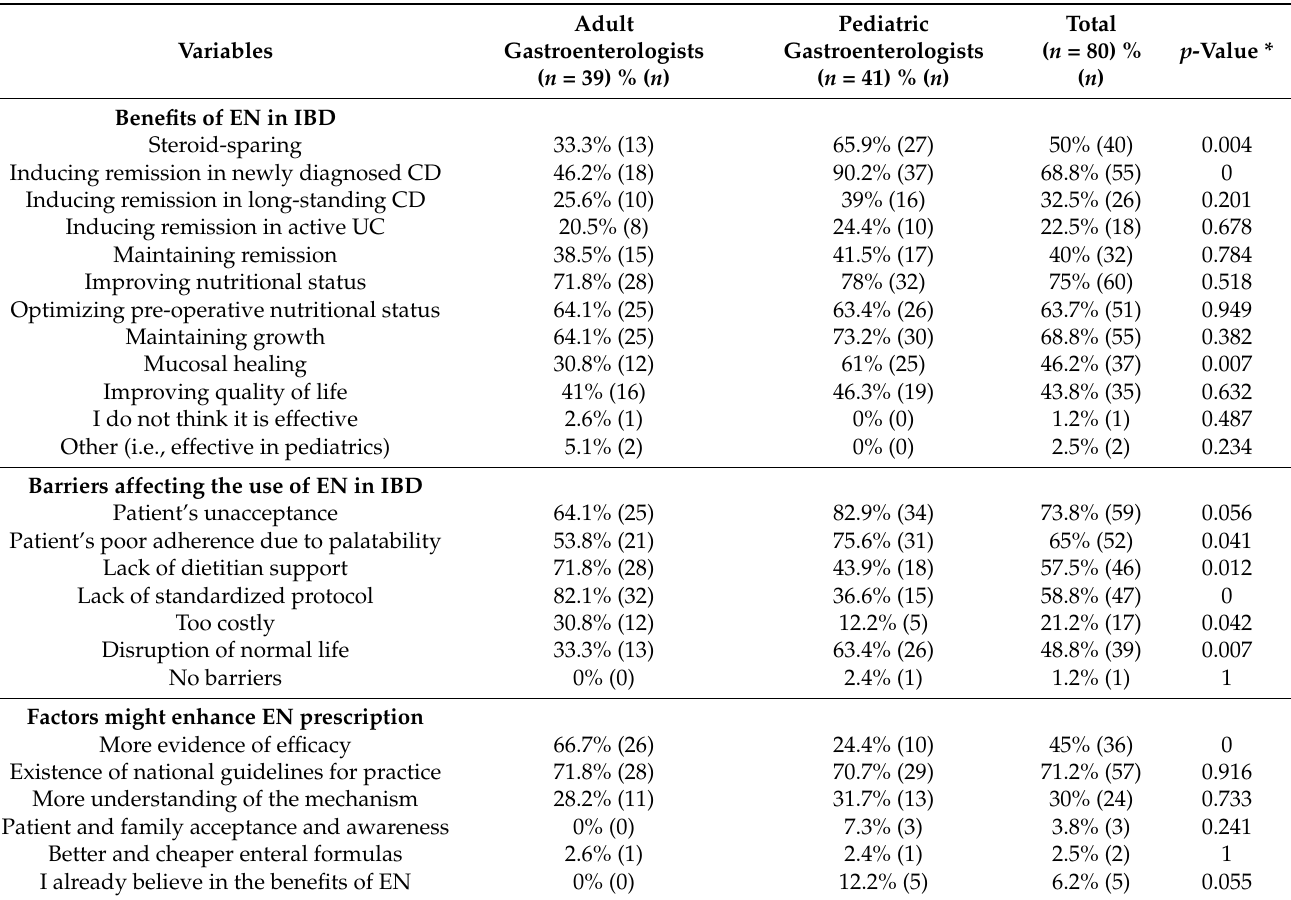
Table 5. Gastroenterologists’ perception of benefits of and barriers to prescribing any form of EN in